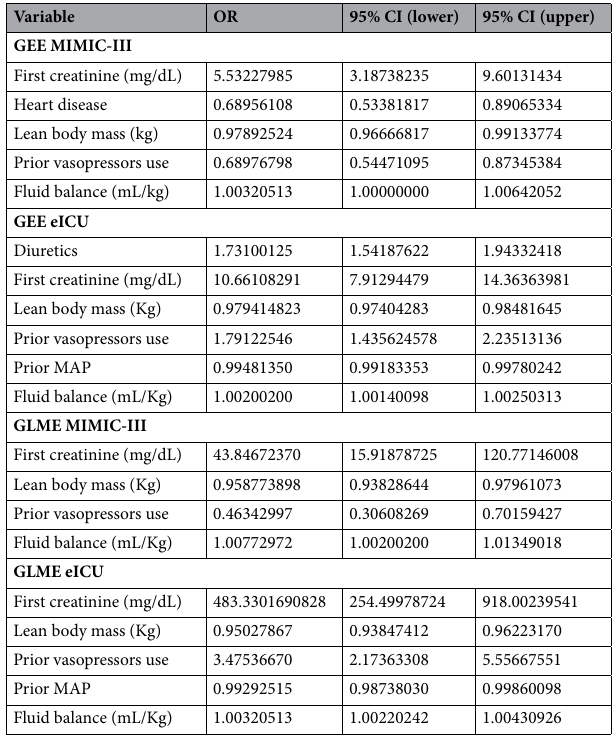
Table 2. GEE and GLME multivariable models’ estimated parameters. Estimated parameters of best performing GEE and GLME models based on AUC values, which has a 4 h window length: odds ratio, and 95% confidence interval for the significant covariates for MIMIC-III and eICU.